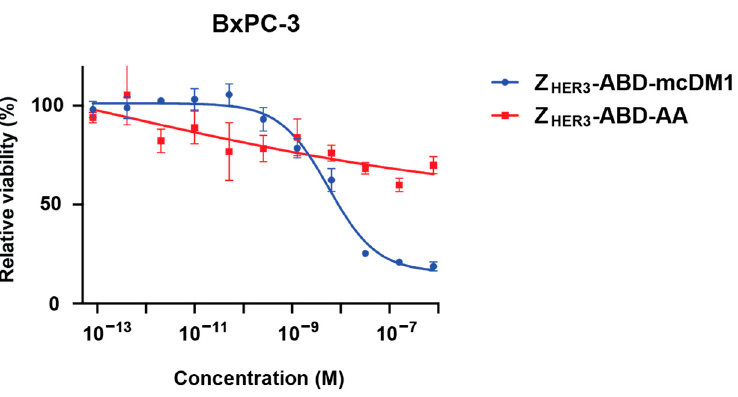
Figure 3. Effect on viability on the human pancreatic cancer cell line BxPC-3 by Z HER3 -ABD-mcDM1 and Z HER3 -ABD-AA. The cells were incubated with different concentrations of the constructs ( x -axis), followed by the measurement of cell viability ( y -axis). The viability of cells grown without the addition of any construct was set to 100%. Each data point is the average of four experiments. The error bars correspond to 1 SD.